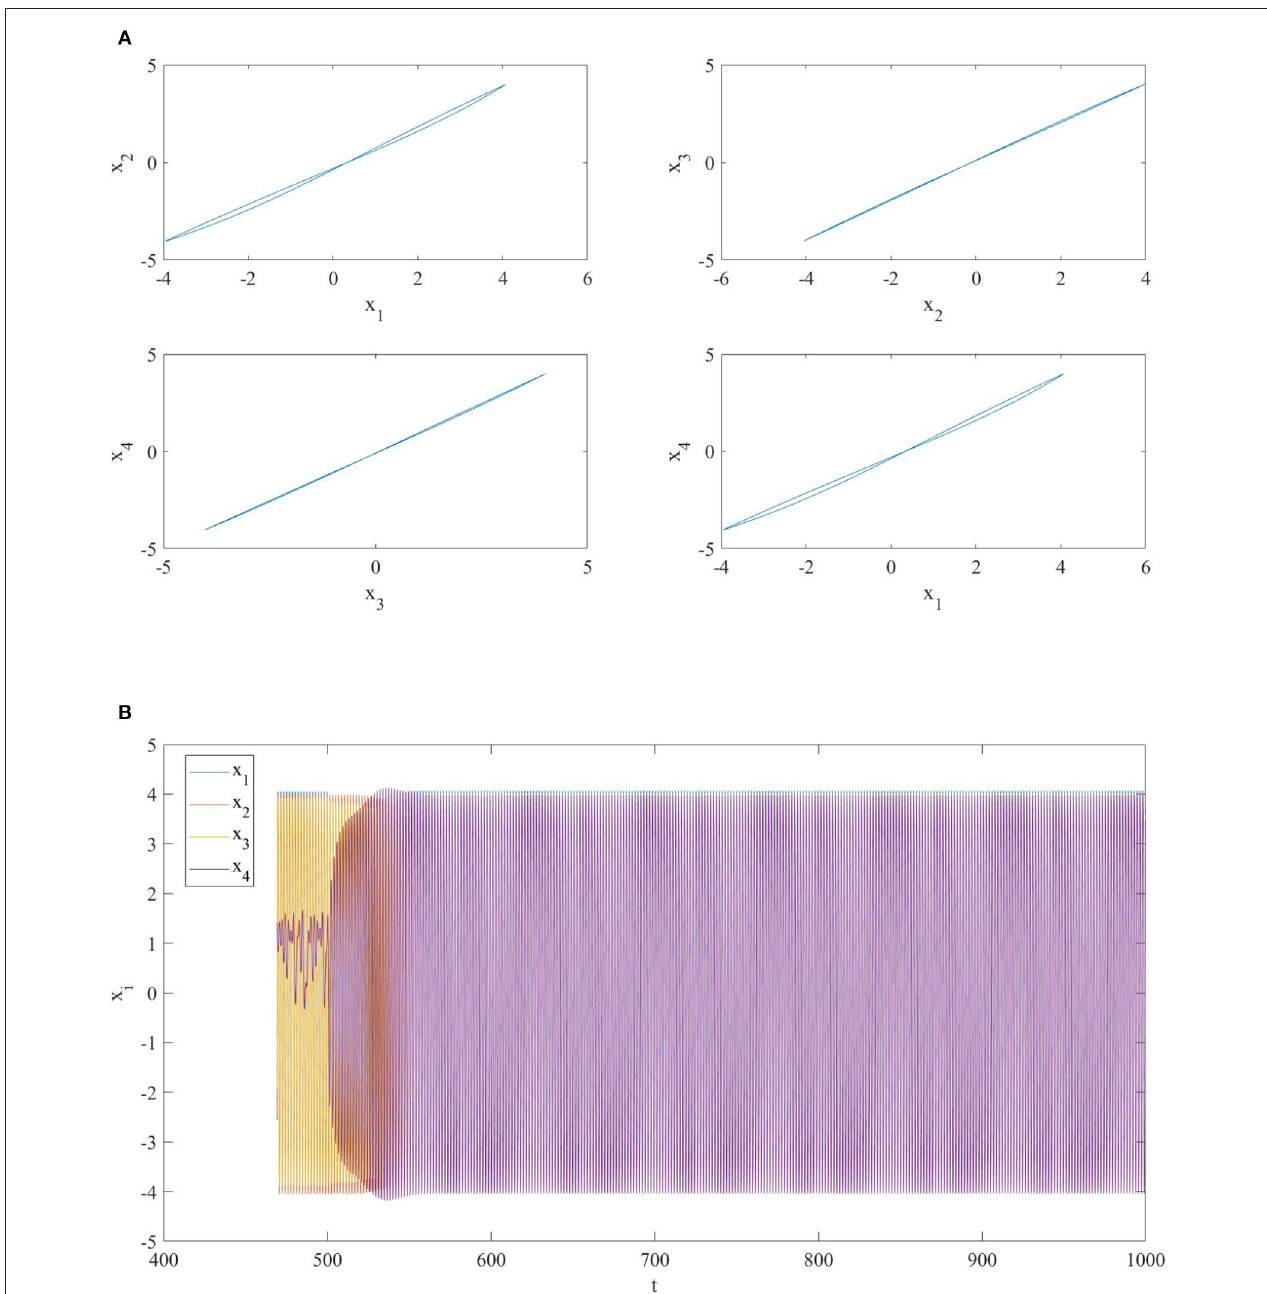
FIGURE 5 | (A) Phase portrait and (B) time series of a network of four diffusively coupled MOCs when a link between the second and the fourth oscillator is added at t = 500. The addition of the new link makes the fourth MOC to synchronize with the